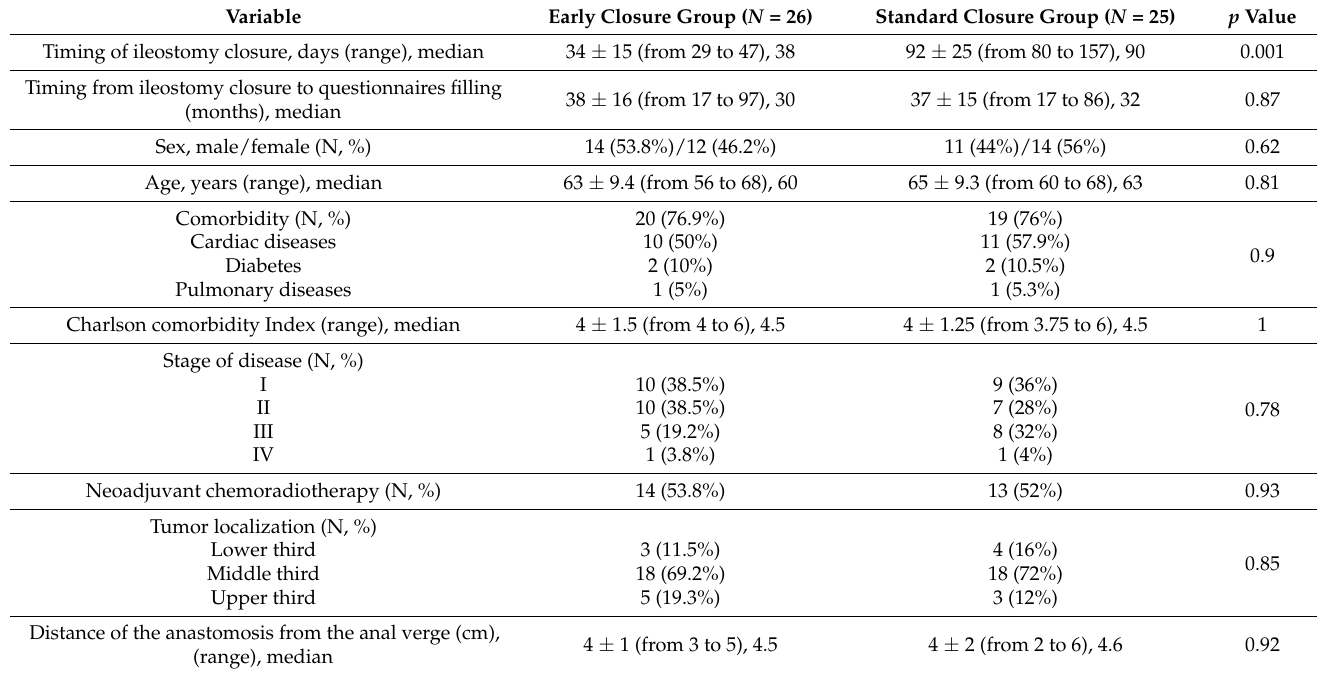
Table 1. Baseline demographic and clinicopathologic characteristics of the study groups